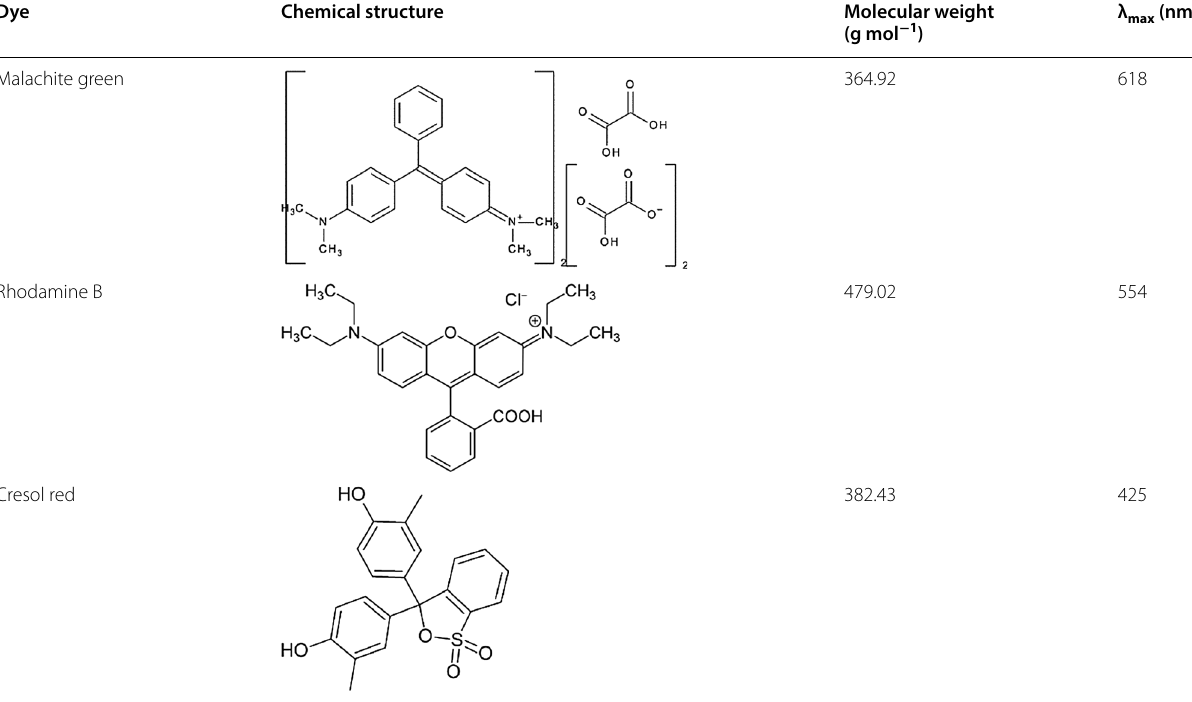
Table 1 Physical and chemical characteristics of adsorbates Dye Chemical